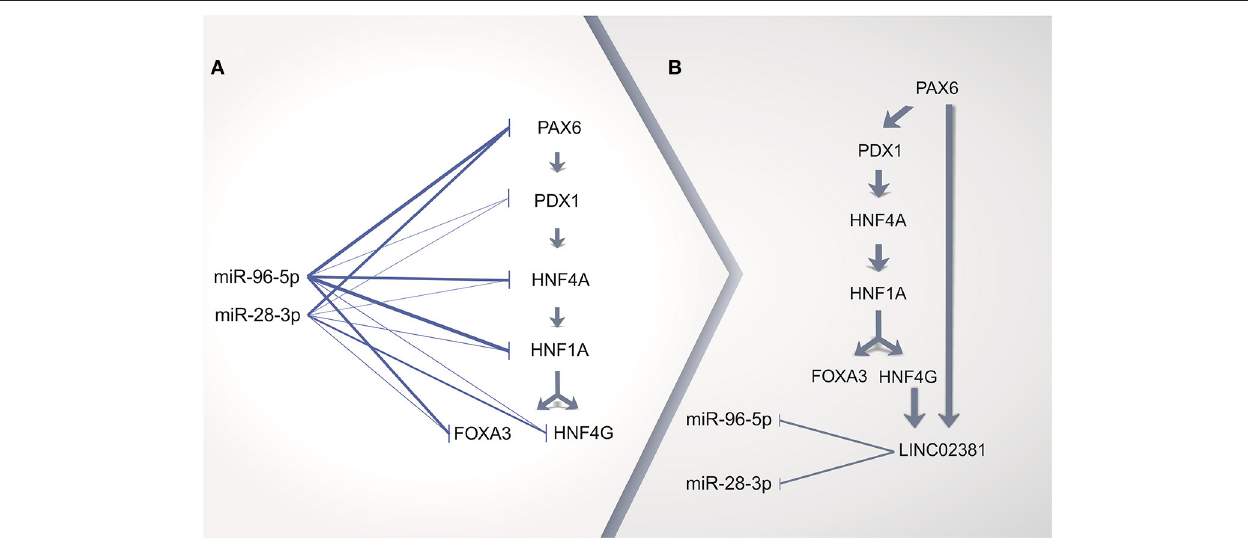
FIGURE 6 | Proposed scheme of cervical adenocarcinoma (ADC) gene regulation by long non-coding RNA (lncRNA) acting as a sponge of microRNA (miRNA). (A) in silico prediction analysis of miRNA repressing all transcription factor (TF) genes upregulated in cervical ADC as compared with squamous cell carcinoma (SCC) in maturity-onset diabetes of the young (MODY) KEGG pathway. (B) TF genes HNF4G and PAX6 might upregulate LINC02381 lncRNA, which could act as a miRNA sponge, as positive feedback for all TF genes pathway expression. Thicker lines on (A) represent more positive predictions of miRNA targeting to a given mRNA ( Supplementary Table 5